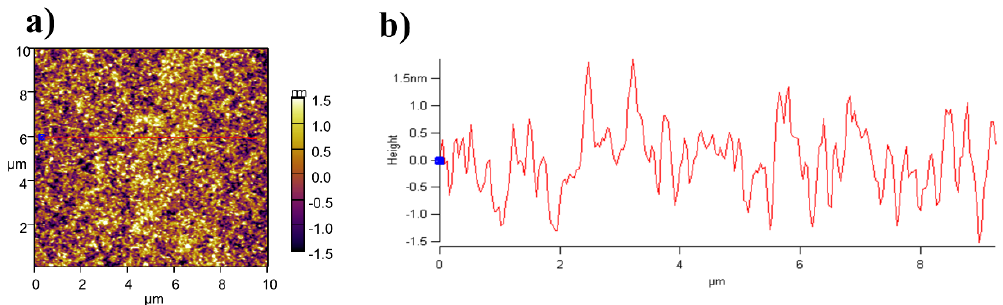
Figure 5. Measured atomic force microscopy (AFM) image of BHJ with a thickness of 320 nm: ( a ) top view of AFM; ( b ) measured cross-section of BHJ.